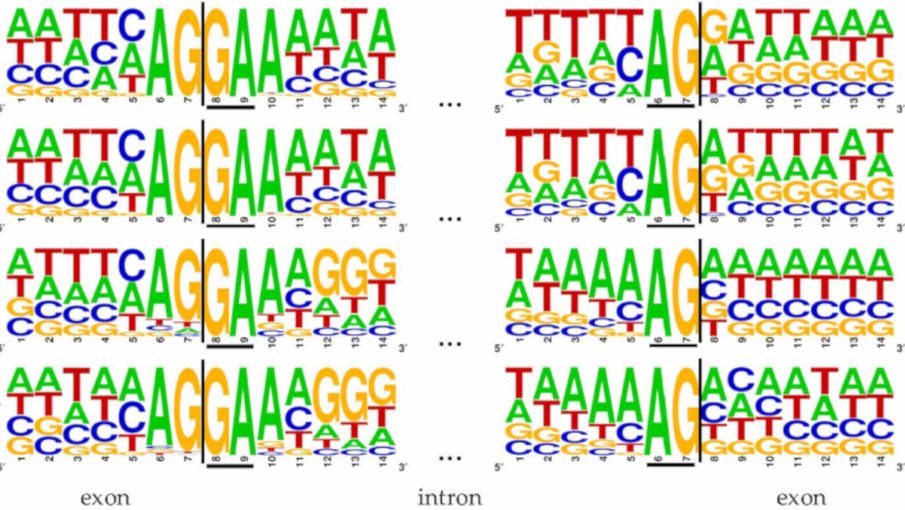
Figure 2. Flanking positions of GA-AG splice site combinations in Eurytemora a ffi nis ( a , b ) and Oikopleura dioica ( c , d ). All splice site combinations ( a , c ) as well as all 5795 with RNA-Seq data supported splice site combinations ( b , d ) of these two species were investigated. Seven exonic and seven intronic positions are displayed at the 5 (cid:48) and 3 (cid:48) splice sites. Underlined bases represent the terminal dinucleotides of the intron, i.e., the 5 (cid:48) and 3 (cid:48) splice